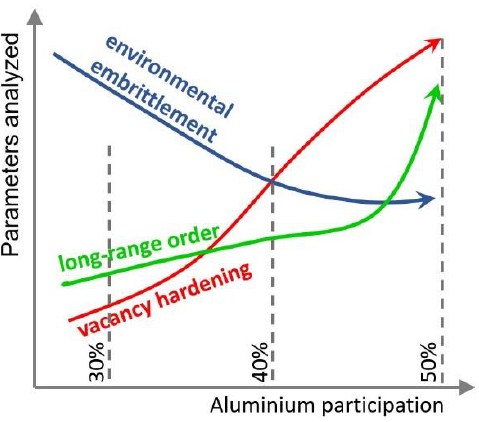
Figure 1. Changes in the factors influencing the brittleness of the FeAl phase depending on the aluminium content. Based on [6 – 17].